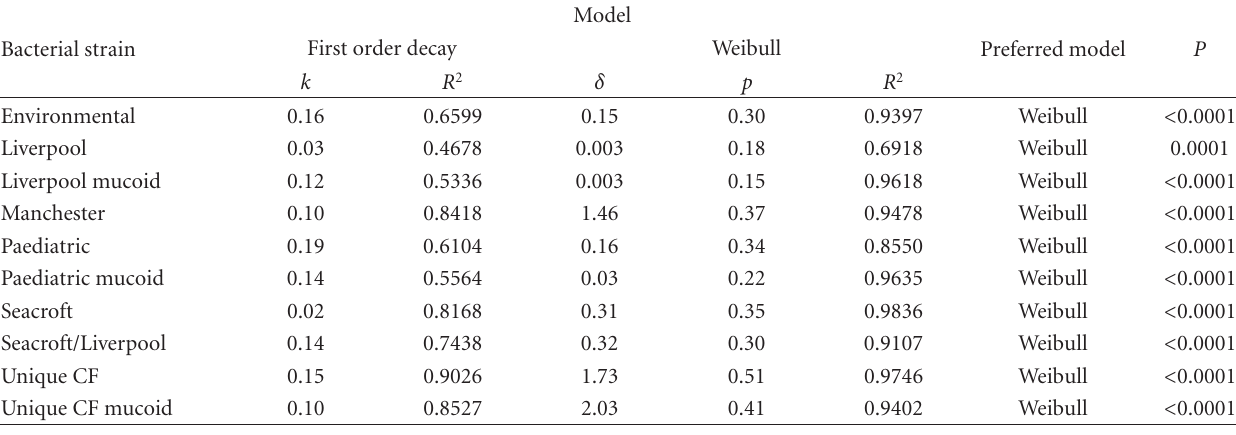
Table 2: Comparison of first order decay and Weibull survival models.